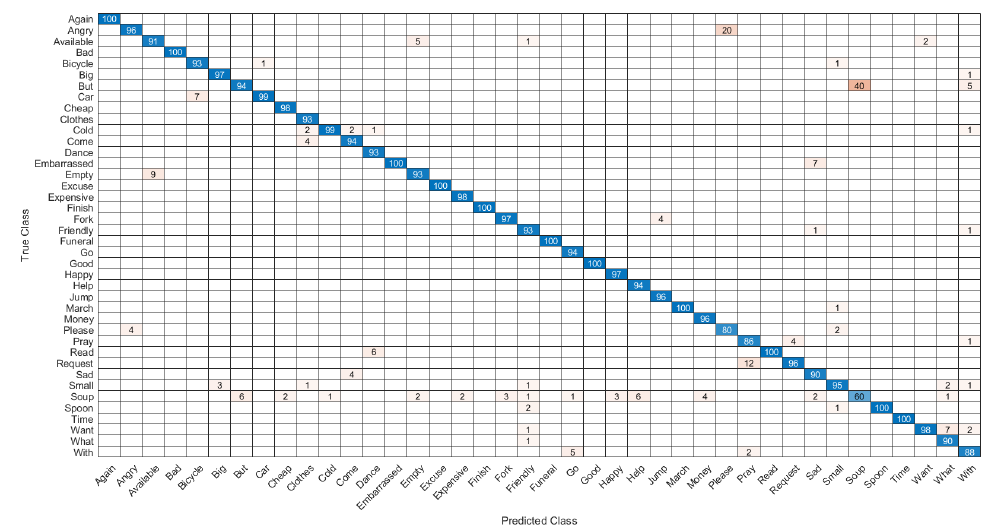
Figure 12. Confusion matrix of the recognition performance of double-hand dynamic ASL words with Adagrad optimization. Table 11. Performance validation of Multi-stack deep BiLSTM from adopted optimization scheme.